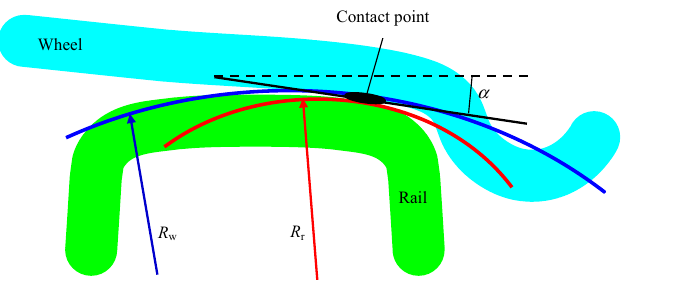
Fig. 3 Sketch of wheel/rail contact